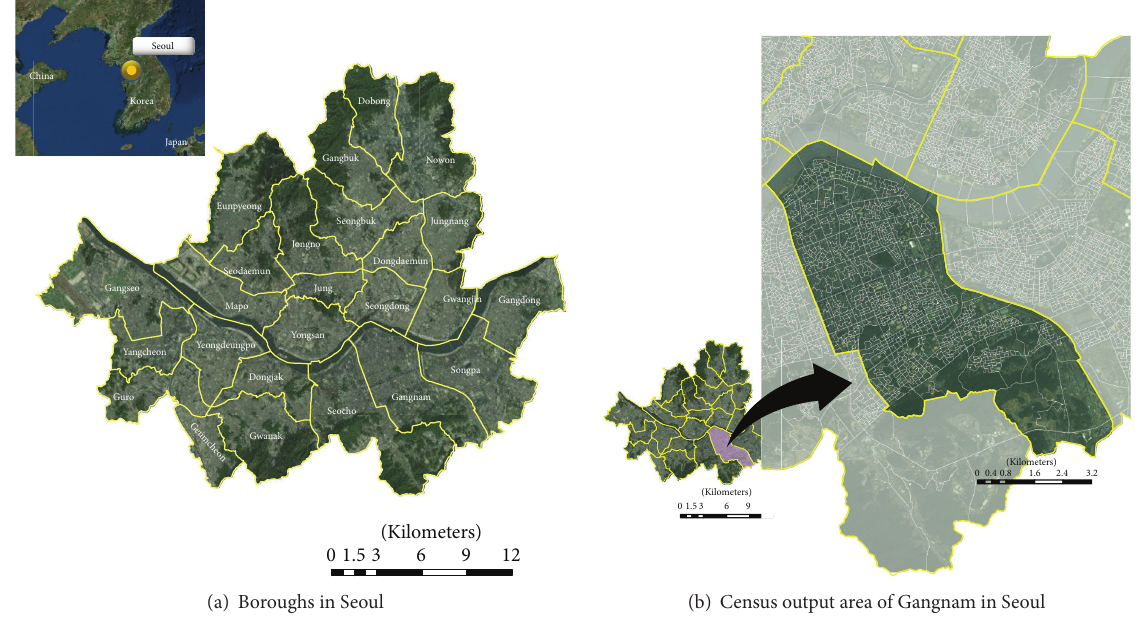
Figure 1: Study area, Seoul, South Korea, with Census Output